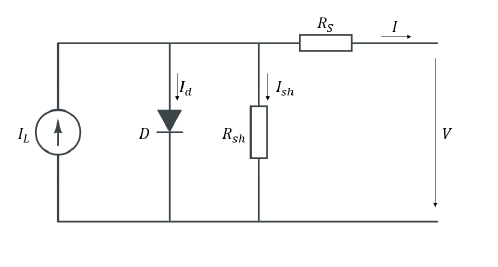
Figure 1. The 1M5P equivalent circuit model of a photovoltaic solar